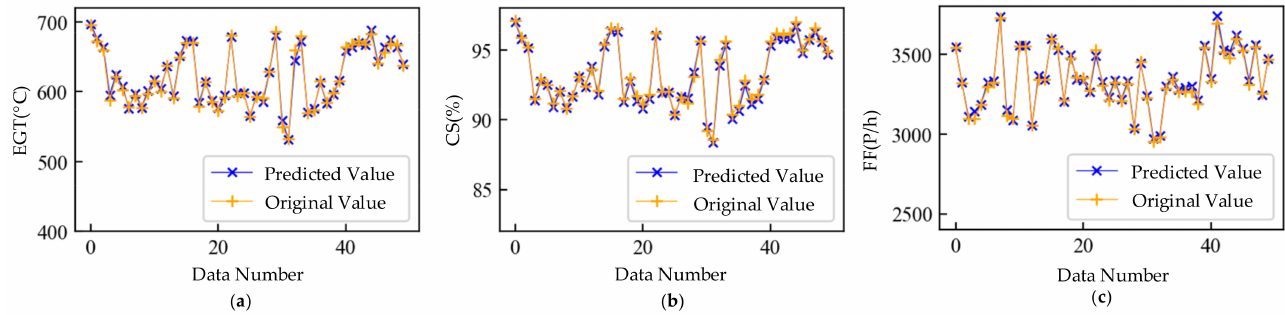
Figure 8. Result of mapping relation mining trained with mixed data. ( a ) Predicted and original values of exhaust gas temperature; ( b ) predicted and original values of core speed; ( c ) predicted and original values of fuel